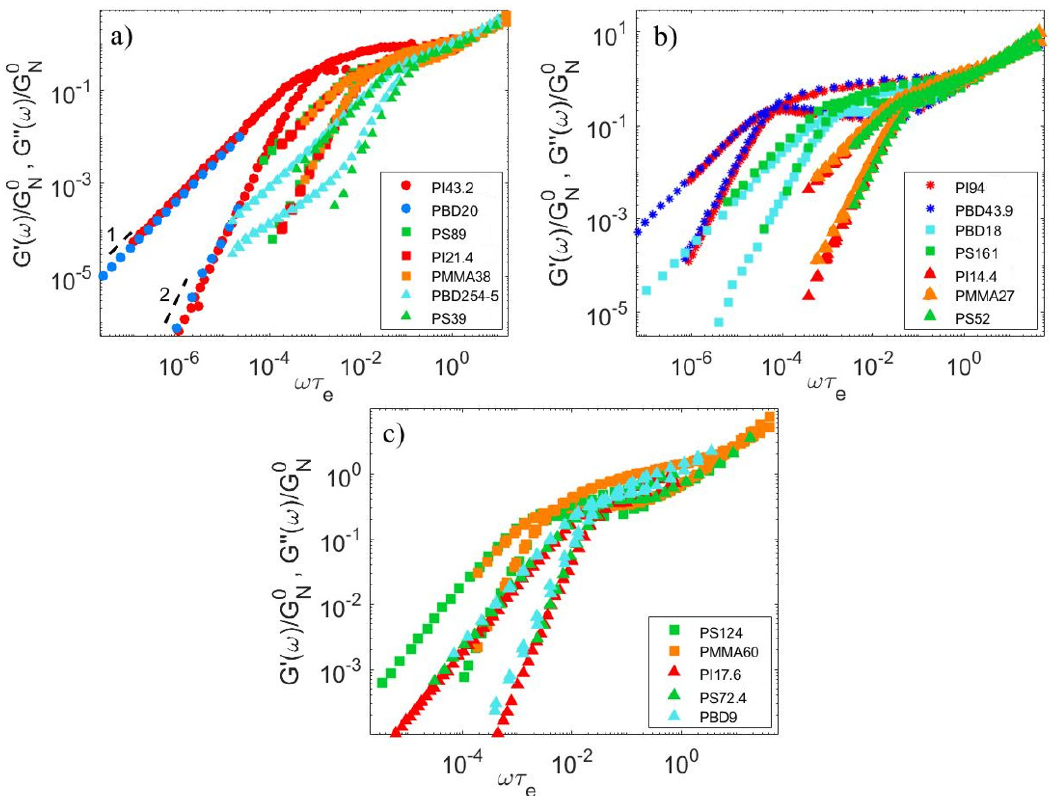
Figure 4. Comparison between normalized storage and loss moduli data of monodisperse samples with different polymer chemistries but the same number of entanglements Z, with ( a ) Z = 3 ( ▲ ), 6 ( ■ ) and 12 ( ● ), with ( b ) Z = 4 ( ▲ ), 11 ( ■ ), and 26 ( ● ), and with ( c ) Z = 5 ( ▲ ) and 9 ( ■ ) [6,13,14,16–18,20,21].